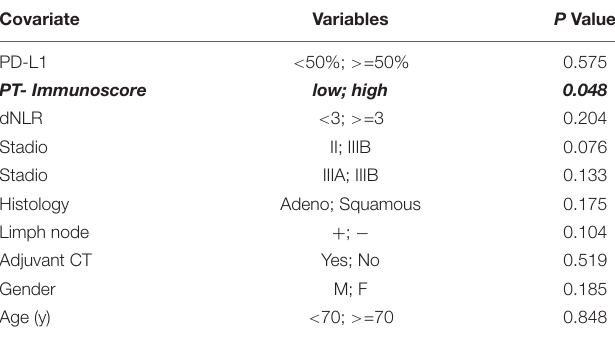
TABLE 5 | Multivariate analysis showing the impact of different covariates on overall survival.